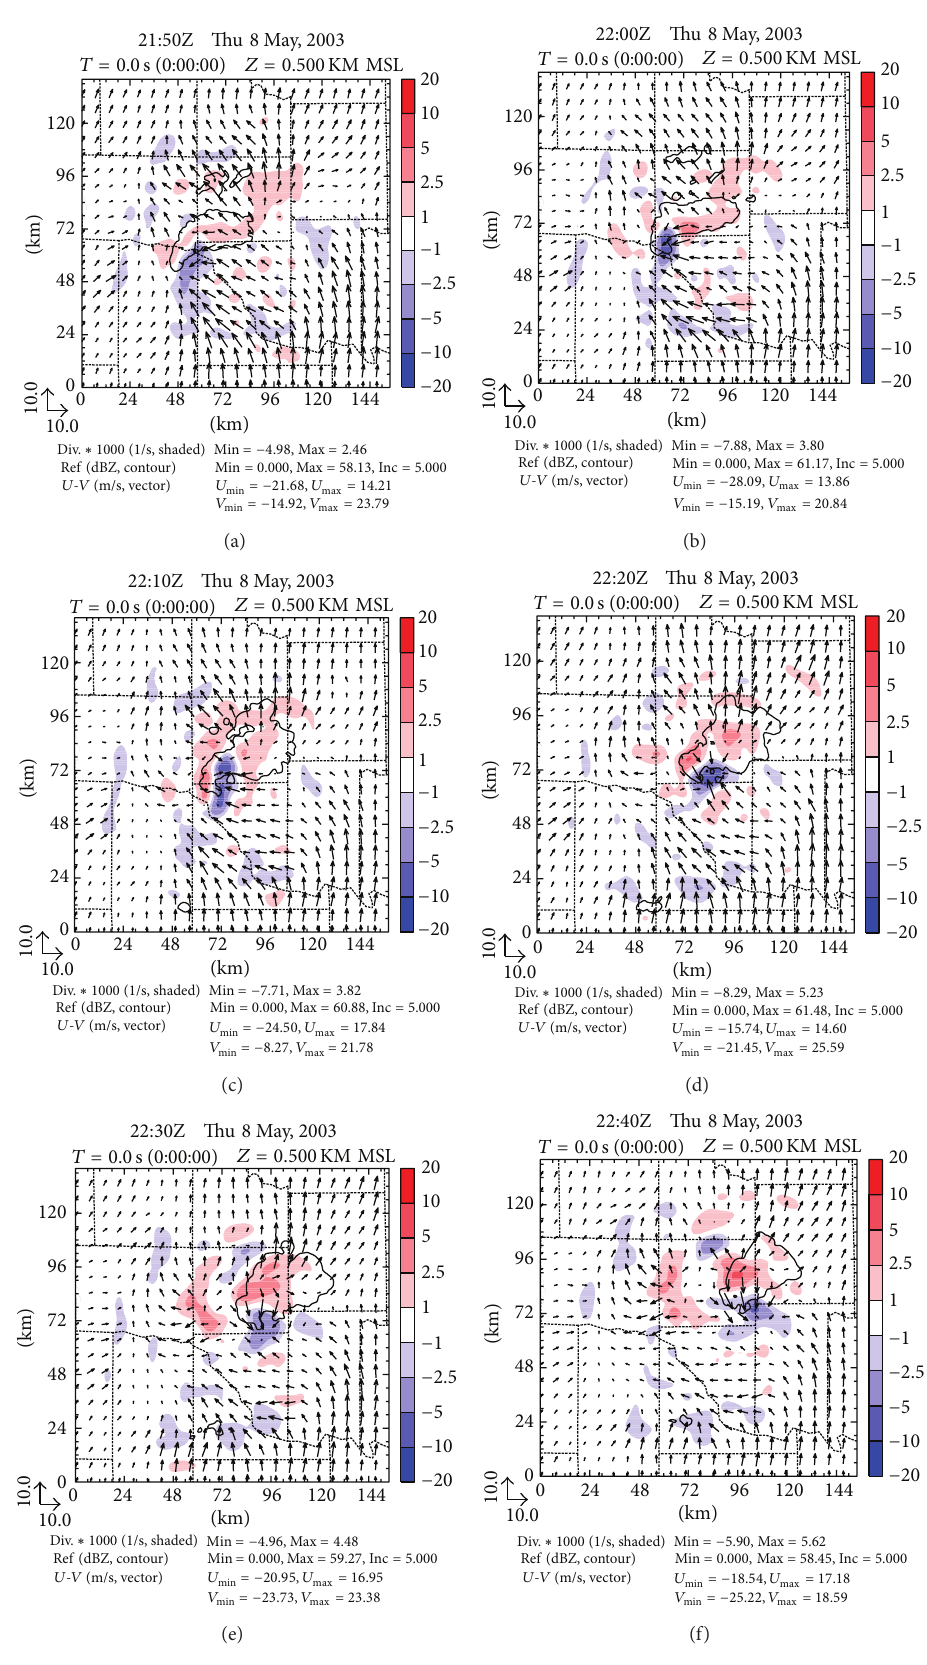
Figure 6: 0.5km horizontal divergence (10 −3 s −1 ) and horizontal wind vectors with the 35 dBZ reflectivity contour outlined from the control analysis from (a) 2150 UTC to (f) 2240UTC at 10-minute